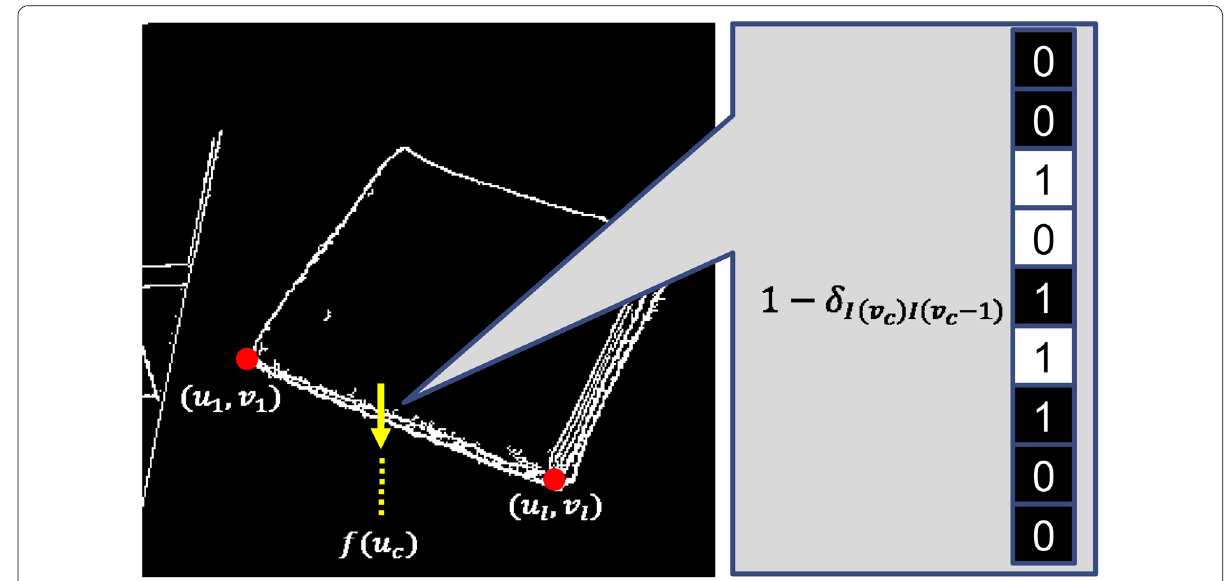
Fig. 4 Counting the number of edges from the result of canny edge